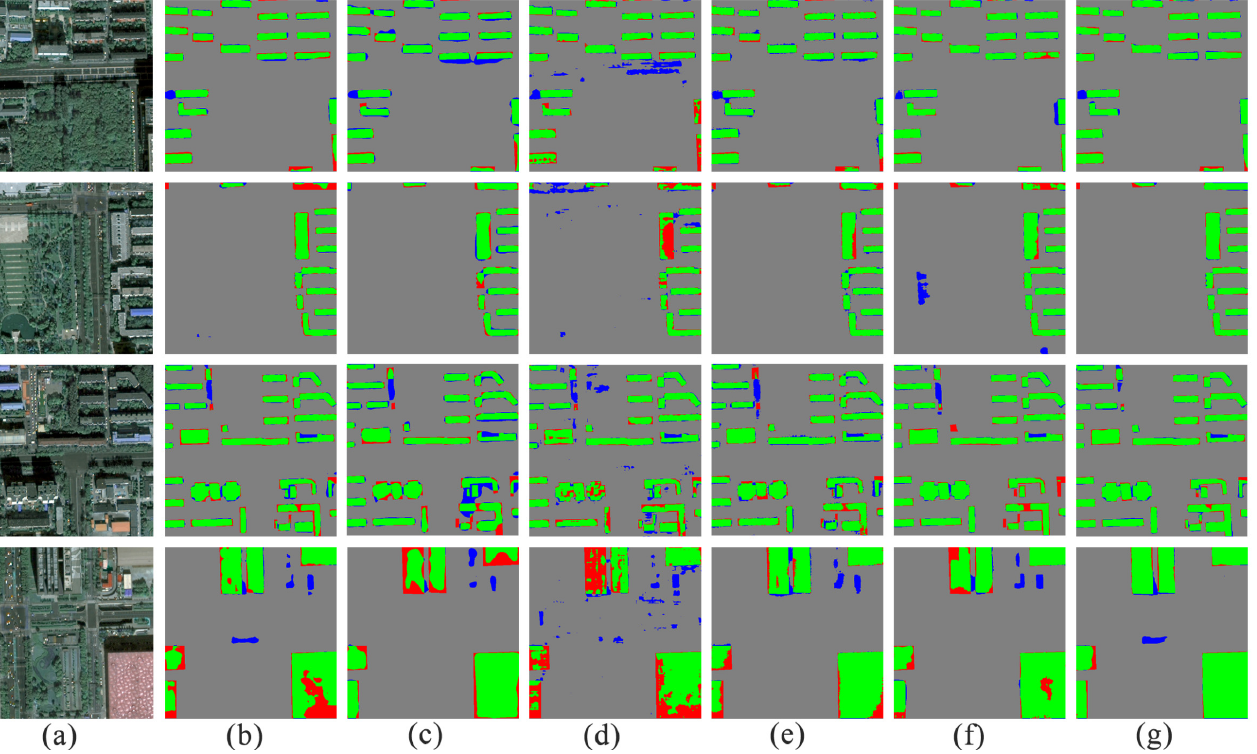
Figure 10. Example of the results with the PSPNet, FCN, DeepLab v3+, SegNet, U-Net, and our proposed method using the GF-7 self-annotated building dataset: ( a ) Original image. ( b ) PSPNet. ( c ) FCN. ( d ) DeepLab v3+. ( e ) SegNet. ( f ) U-Net. ( g ) Proposed model.